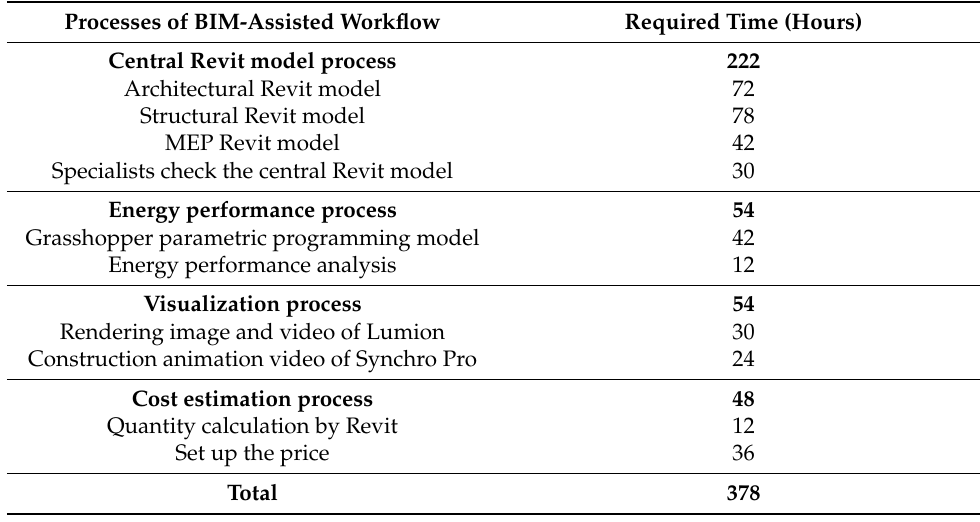
Table 4. Duration results of BIM-assisted workflow simulation.